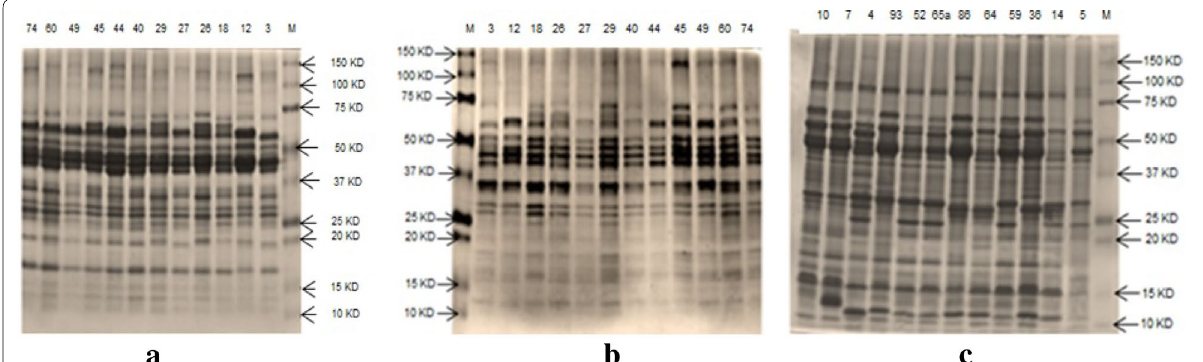
Fig. 2 Electrophoretic banding pattern generated by SDS-PAGE of seed storage proteins of some Vicia accessions studied. M marker, a globulins, b prolamins, c albumins